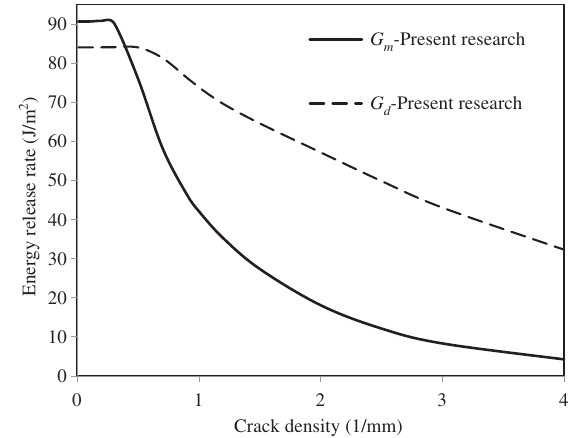
] s carbon/ 3 = 10 MPa. 2